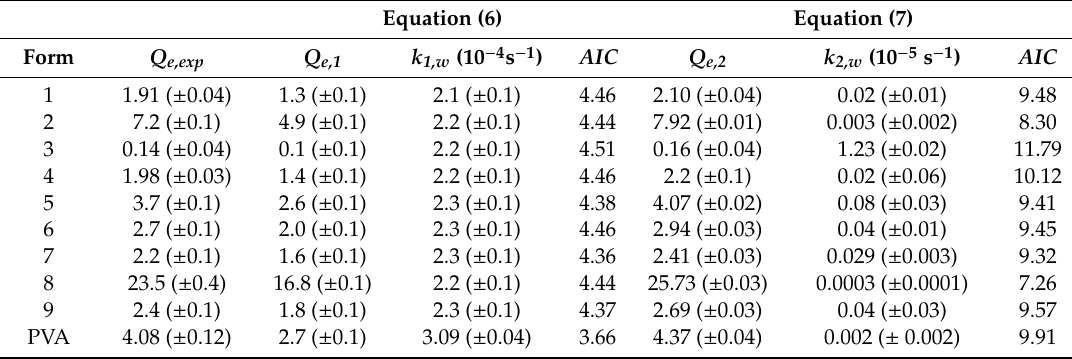
Table 2. Kinetic parameters for the swelling of water by PVA / CS / MA- β -CD-based blends gels, at 25 ◦ C (see Table S2).